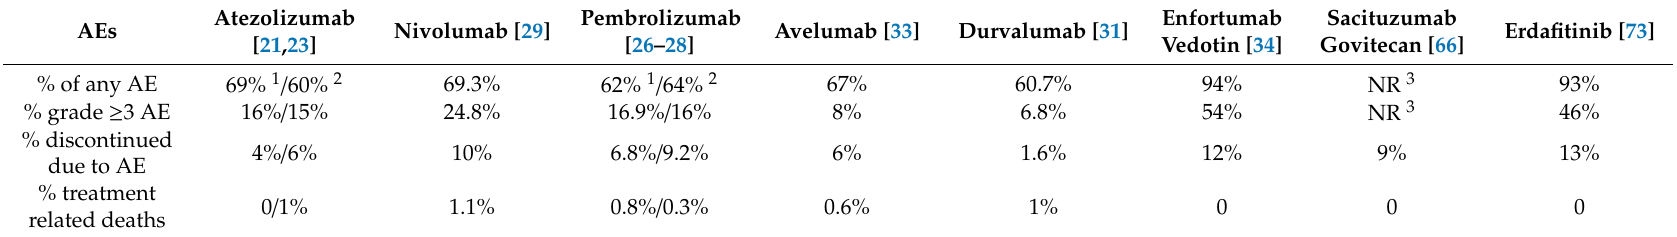
Table 2. Treatment-related adverse events (AEs) from ICIs and targeted